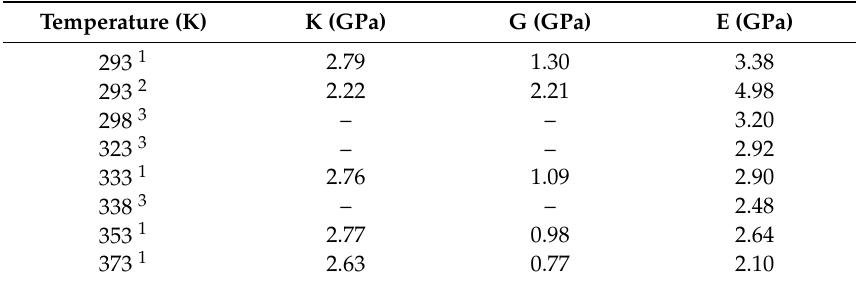
Figure 3. Modulus curve of PBX at di ff erent temperatures. K = bulk modulus, G = shear modulus, and E = Young’s modulus. Table 2. Mechanical properties of PBX at di ff erent temperatures. K = bulk modulus, G = shear modulus, and E = Young’s modulus.